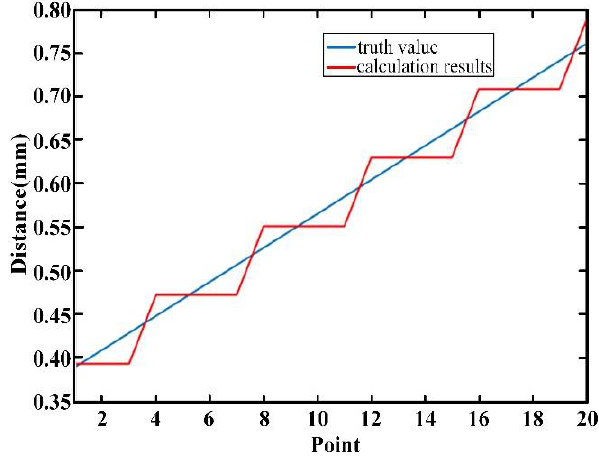
Figure 4. Simulation of resolution of dispersion interference ranging.